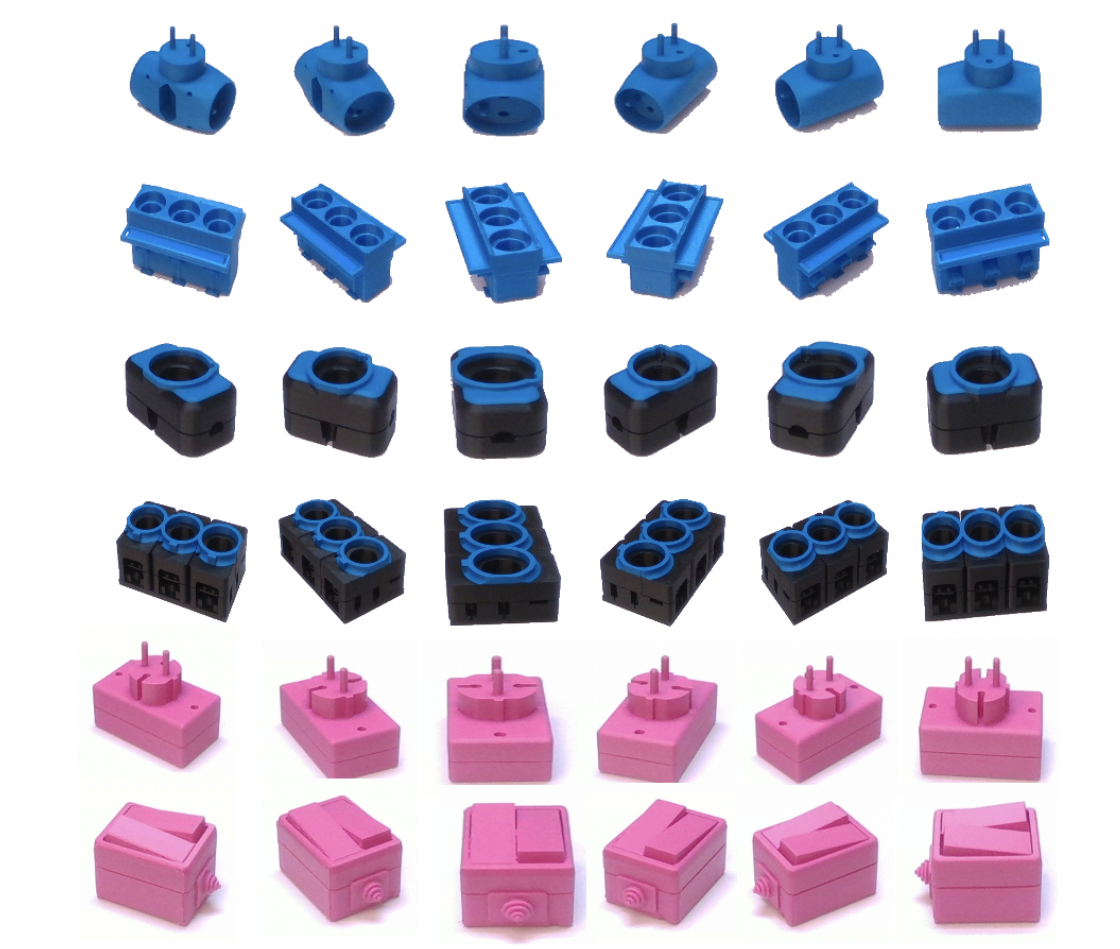
Figure 8. A subset of training set corresponding to objects 5, 7, 9, 21, 22 and 25 of the Tless dataset.